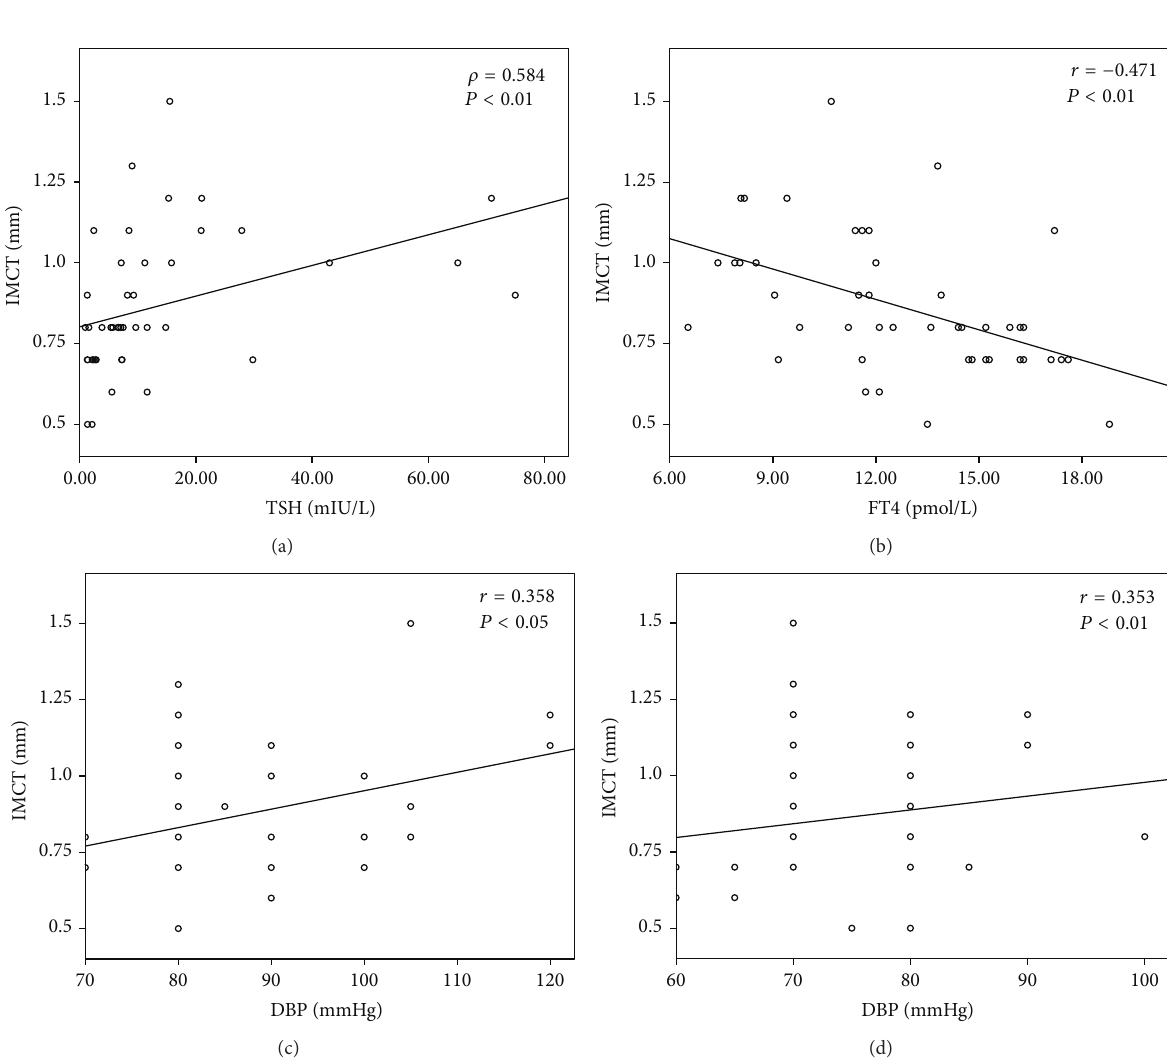
Figure 4: Correlation analyses between intima media complex thickness (IMCT) and (a) thyroid-stimulating hormone (TSH), (b) free thyroxine (FT4), and (c) diastolic blood pressure (DBP) before and (d) DBP after LT4 replacement treatment; 𝑟 indicates Pearson correlation coefficient; 𝜌 indicates Spearman rank